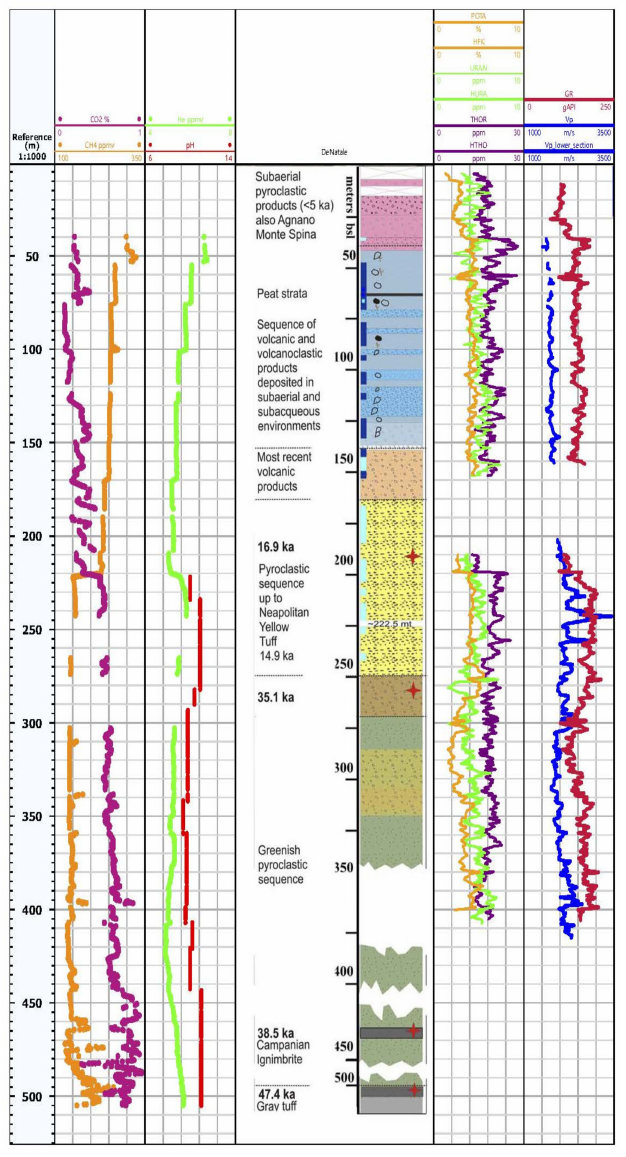
Figure 3. On the left-hand side, depth-profile of CO 2 , CH 4 and He, measured in the drill mud during drilling and associated lithology intercepted by the borehole. On the right-hand side (where the stratigraphic column is not scaled in the lower section and the logging data did not reach total depth of the well); wireline logging measurements (2 intervals) of spectral gamma radiation K, Th, and K content (first track); and total gamma radiation displayed with v p and v s acoustic velocities, on the second